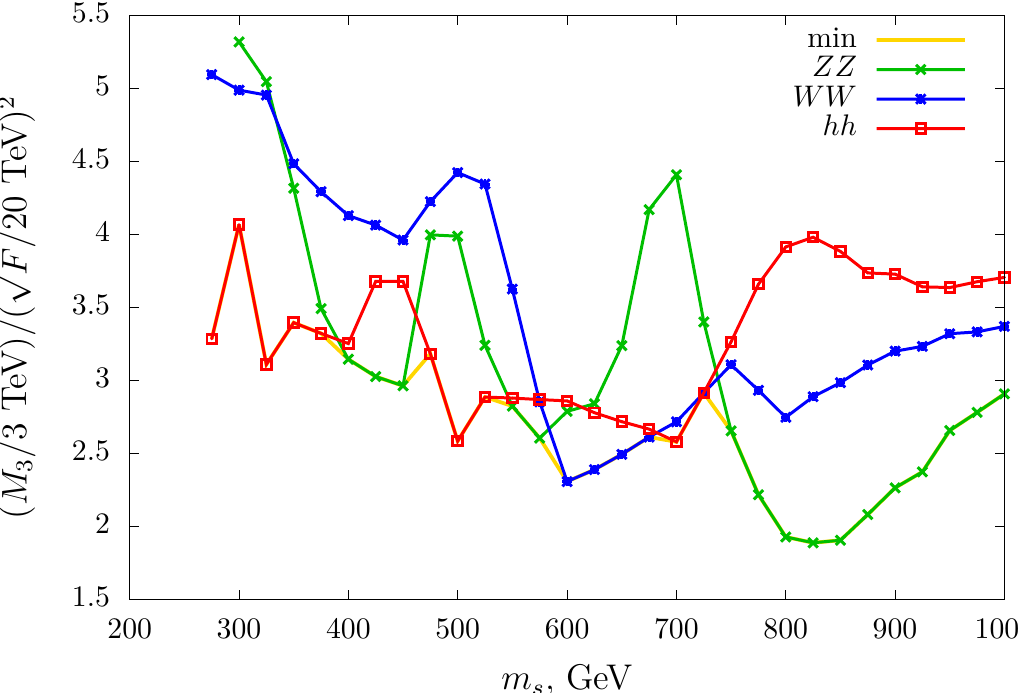
Figure 9. Upper limits at 95% CL on ratio M 3 =F obtained from the experimental data [46{48, 52{ 58] for p S = 13 TeV. Constraints obtained from the searches for a heavy scalar resonance decaying into a pair of Z -bosons, W -bosons and Higgs bosons are shown in green, blue and red, respectively. The yellow line connects points of joint constraint on M 3 =F (minimum upper